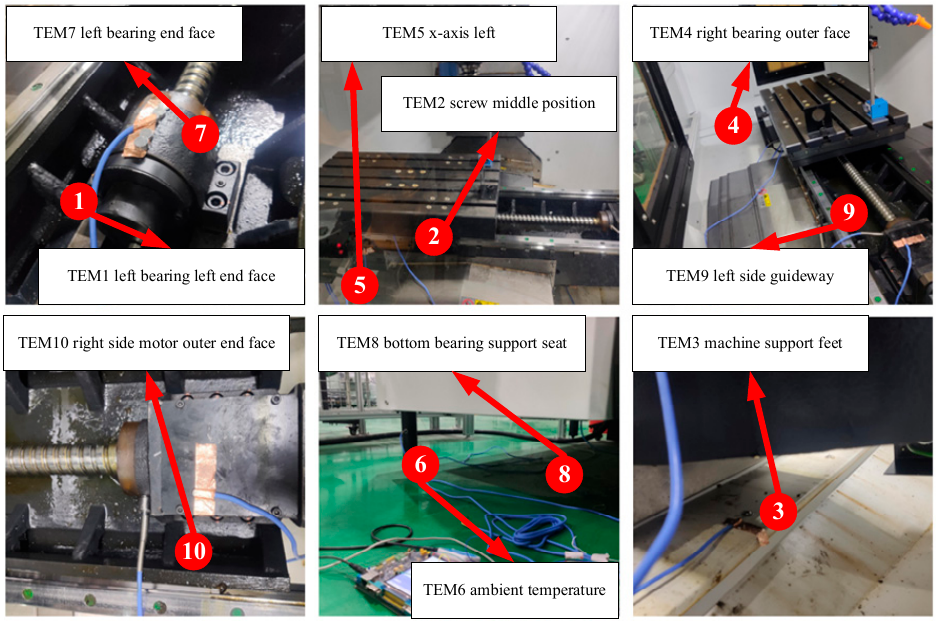
Figure 20. Overall layout of the temperature sensor.